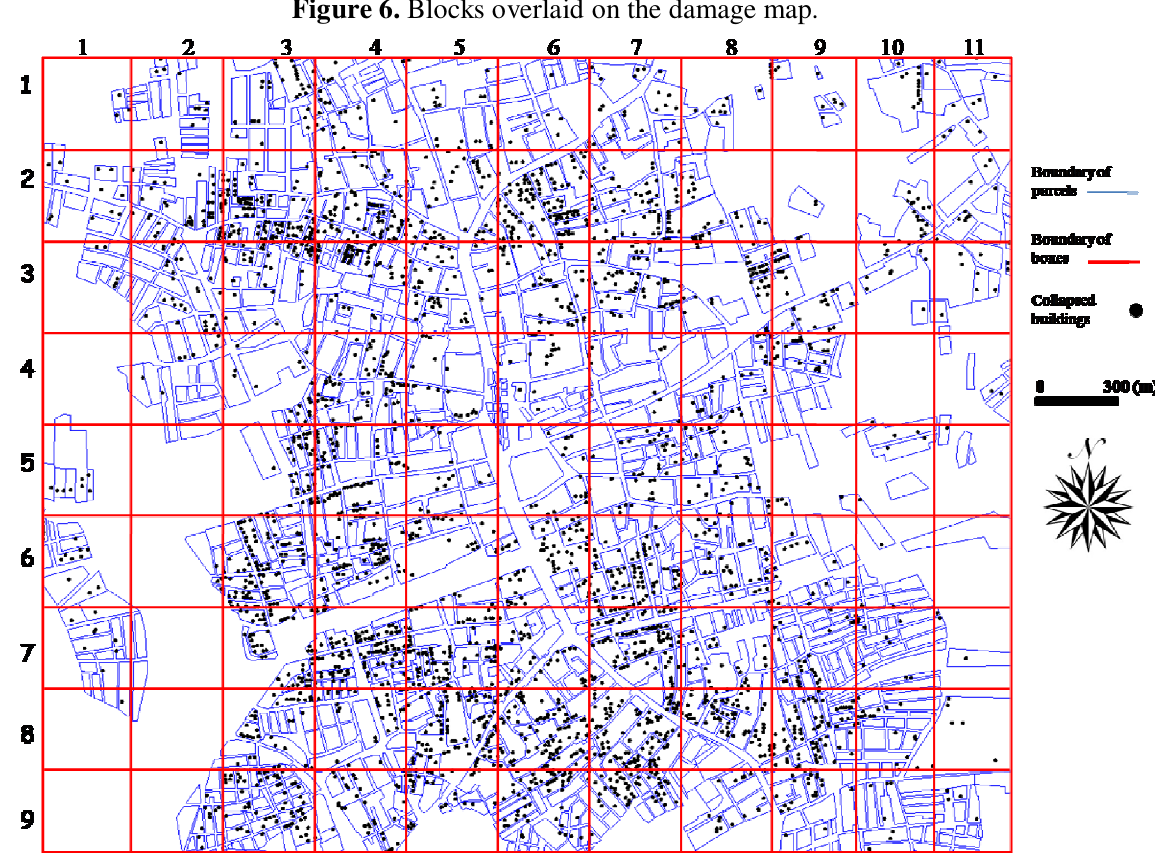
Figure 6. Blocks overlaid on the damage